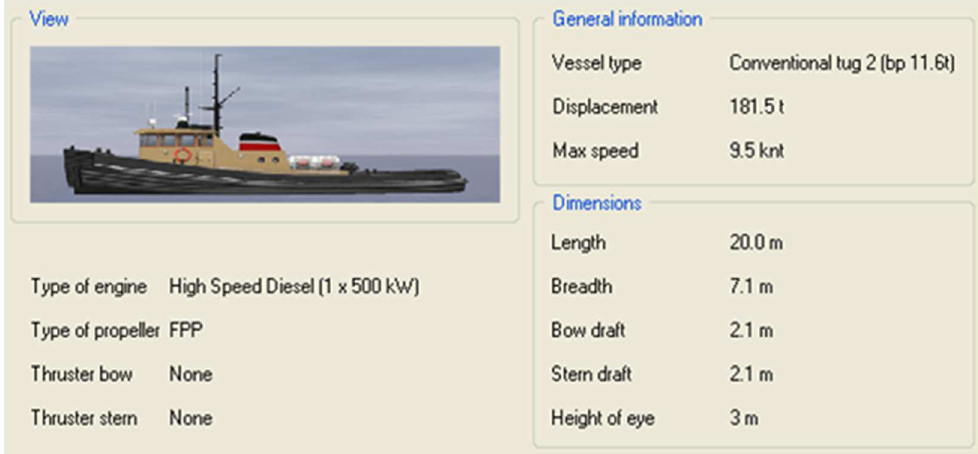
Figure 4. Characteristics of the “Conventional tug 2” model. Source: Navi-Trainer Professional 5000.